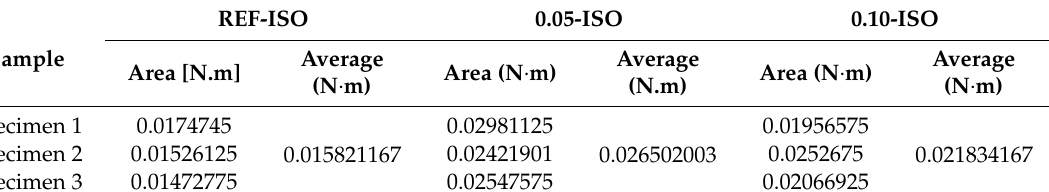
Table 3. Results of the load-displacement curve integration.